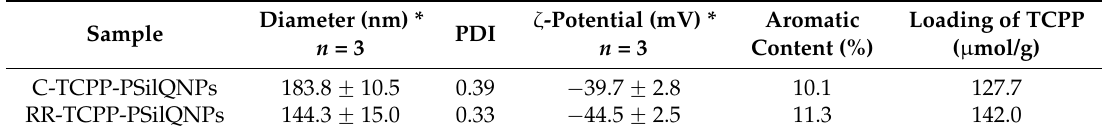
Table 1. Structural properties of control tetrakis(Carboxyphenyl) porphyrin (C-TCPP)- and redox-responsive tetrakis(carboxyphenyl) porphyrin (RR-TCPP)-polysilsesquioxane nanoparticles (PSilQNPs).